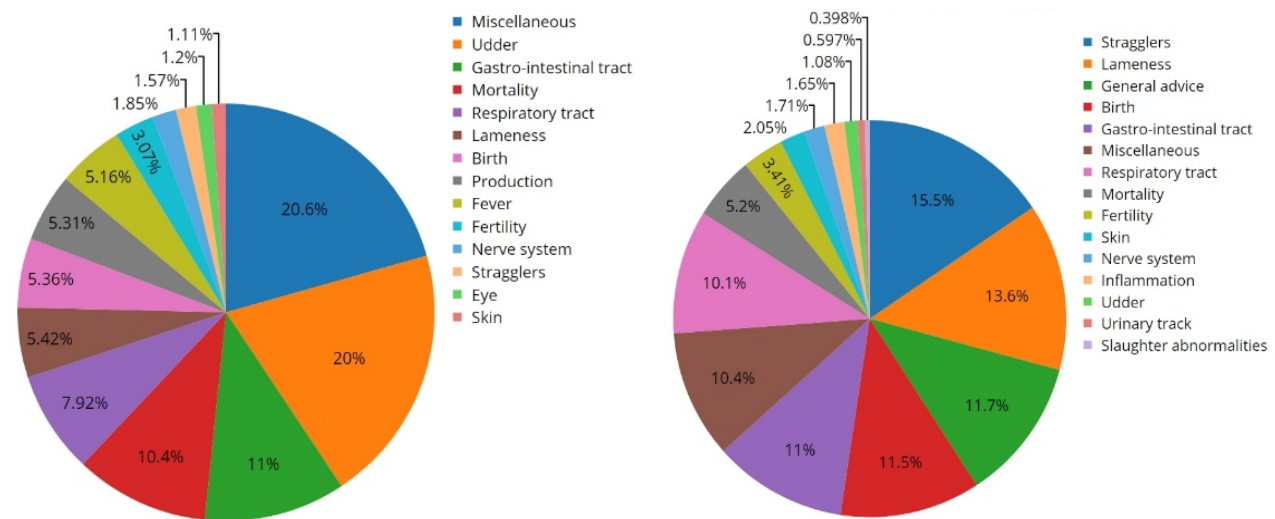
Figure 2. Frequency of reported clinical signs to the veterinary helpdesk for cattle and pigs in the Netherlands, per category as percentages of the total contact with reported clinical signs over the years 2015 to 2019 combined.